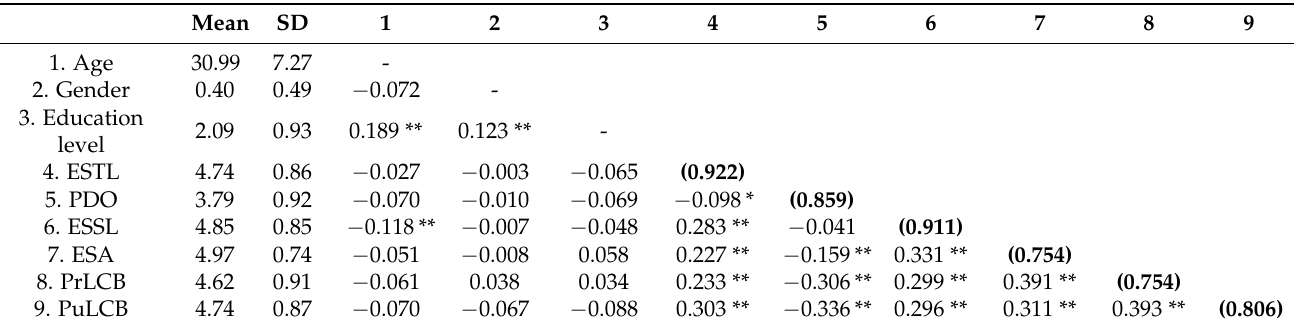
Table 2. Means, standard deviations, and